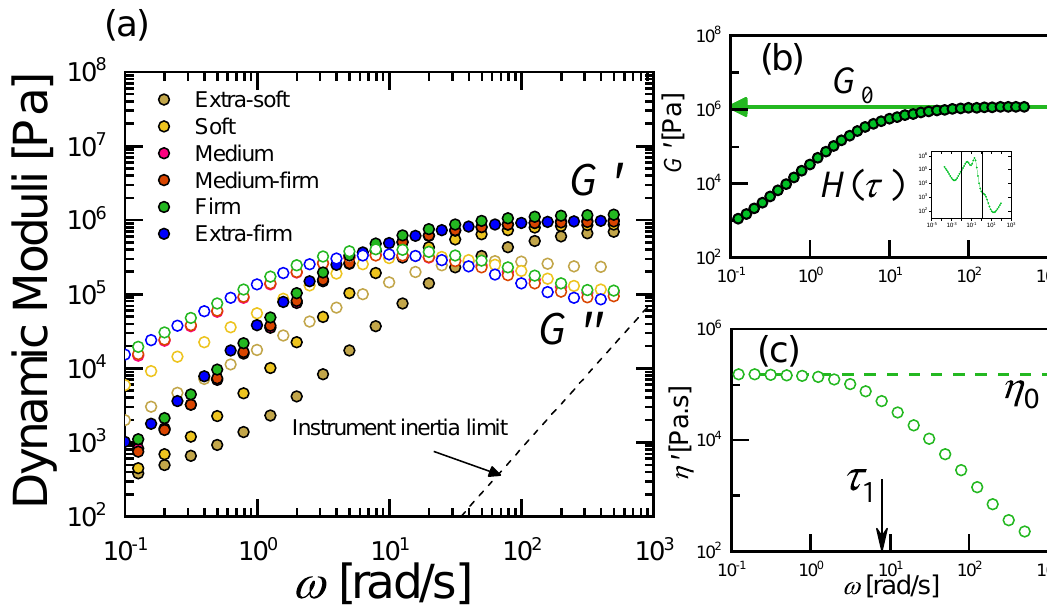
Figure 8: Linear viscoelastic frequency sweeps for the physical therapy putties; input stress amplitude 100 Pa. Uncertainty bars are as- sociated with multiple trials; repeatability falls within the symbol size for all tests. (a) Viscoelastic moduli G ′ (closed) and G ′′ (open) for all samples. (b,c) the “firm” putty data emphasizing the low dimensional quantities G 0 , η 0 , and τ 1 as calculated from the moment of the continuous spectrum shown in an inset to (b). The instrument inertia (dashed line), as defined in [91].